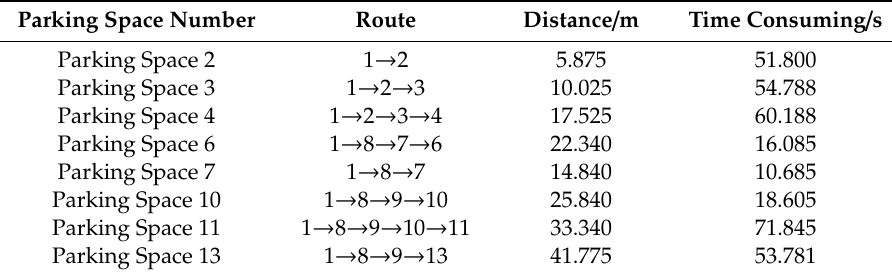
Table 4. Initial driving route of each parking space.